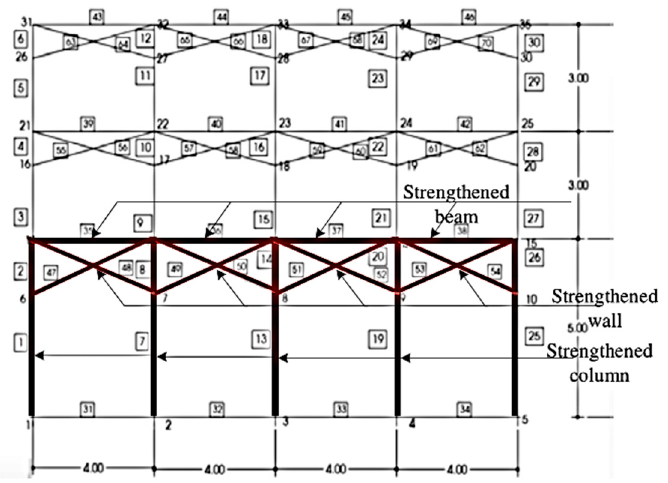
Figure 7. Model of the reinforced building walls.